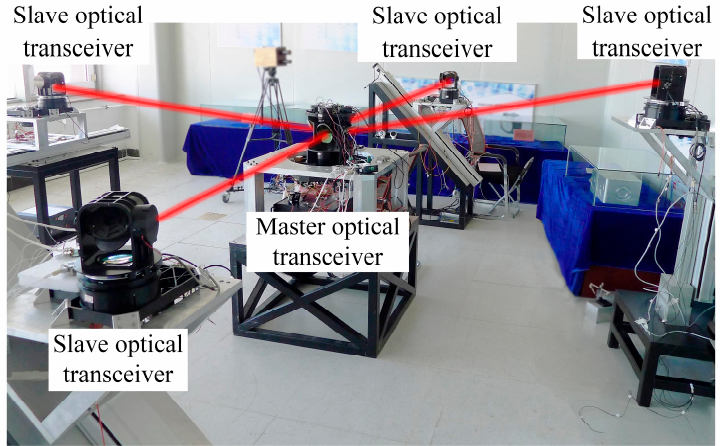
Figure 2. The illustration of the indoor experiment for laser communication networking.